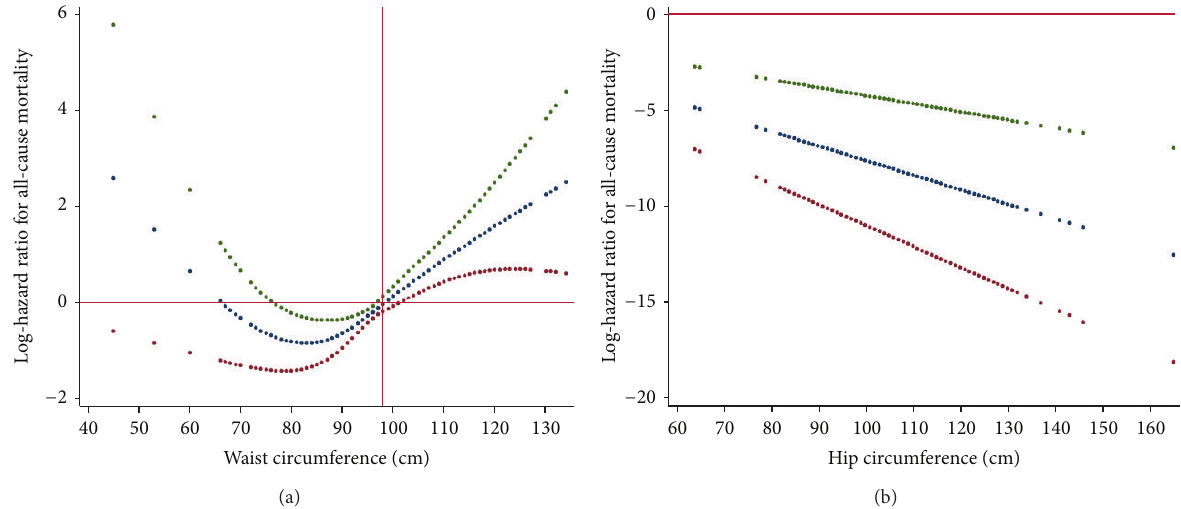
Figure 3: (a) Nonlinear contribution of waist circumference to all-cause mortality. (b) Linear contribution of hip circumference to all-cause